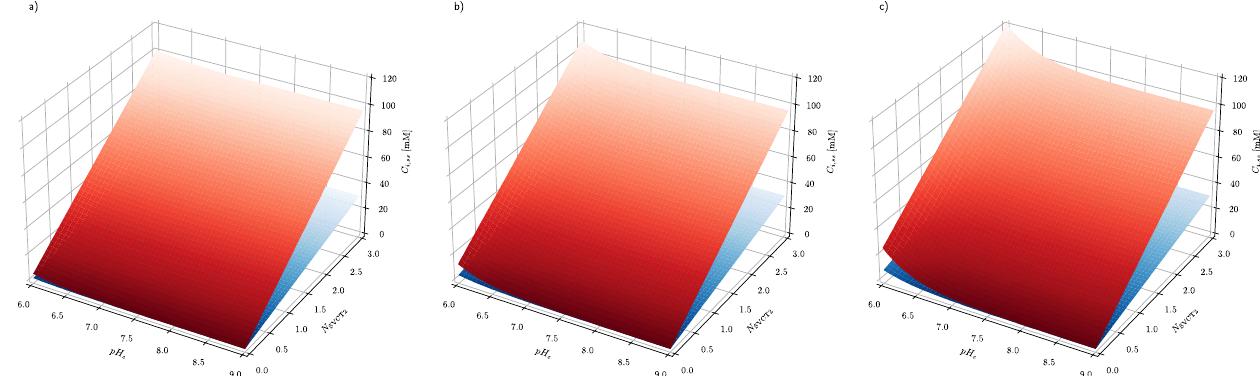
Figure 5. The effect of number of SVCT transporters and extracellular pH on the intracellular steady-state ascorbate concentration for cancer and healthy cells when exposed to ( a ) 0.2 mM ( b ) 0.5 mM ( c ) 1 mM extracellular ascorbate concentrations. Membrane electrical potential and pH equals ∆ φ = − 10 mV, pH i = 7.5 and ∆ φ = − 100 mV, pH i = 7.0 for cancer (red surface) and healthy cells (blue surface), respectively. The N SVCT2 is a number expressed in relative values, where 1 stands for the flux of ascorbate facilitated by transporters expressed in Xenopus oocytes cells [38].